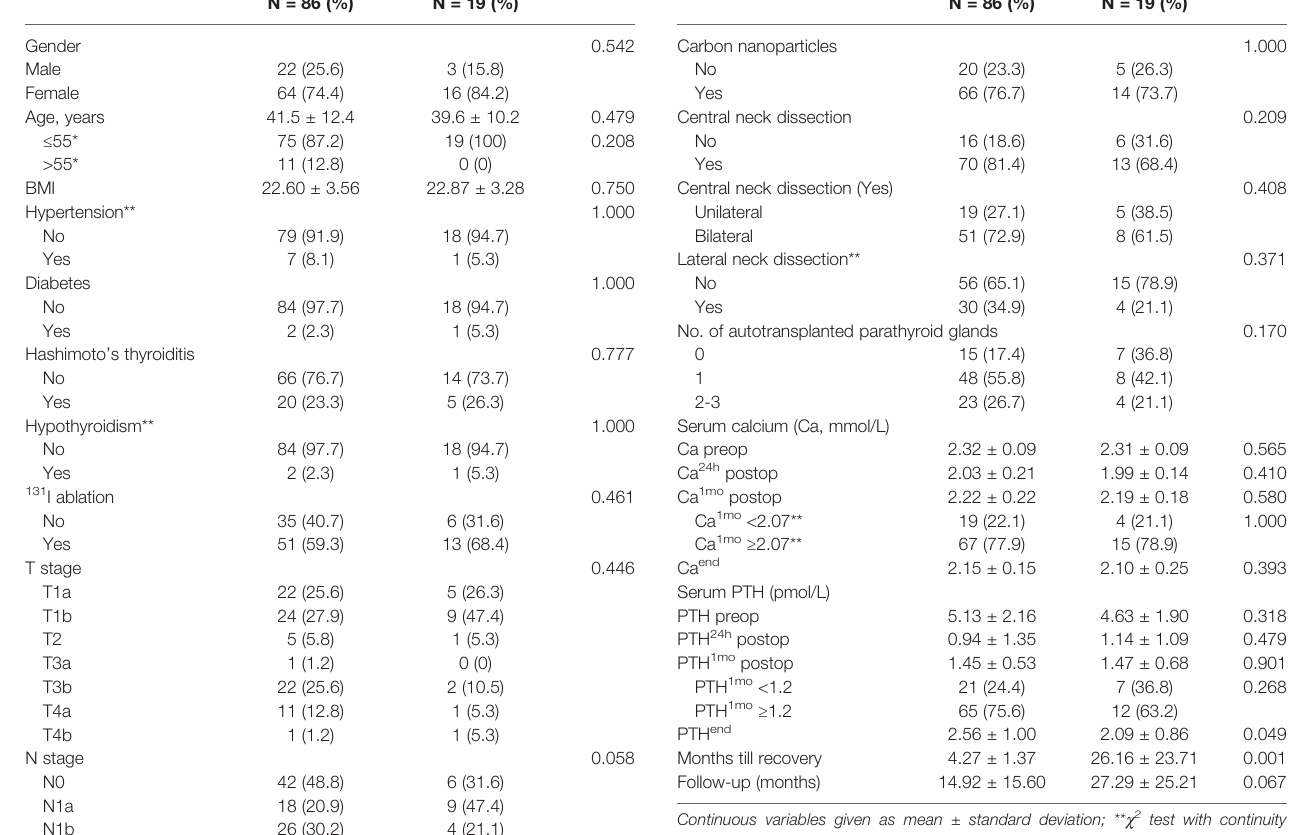
TABLE 4 | Demographic and disease-related variables of patients recovering from protracted hypoparathyroidism within or beyond six months after surgery. Variables